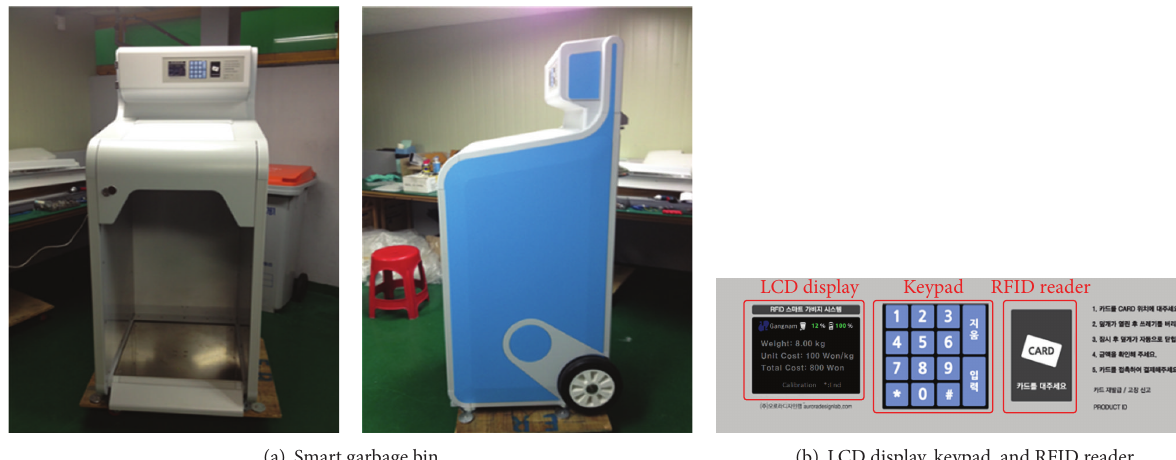
Figure 9: (a) Smart garbage bin and (b) LCD display, keypad, and RFID reader.